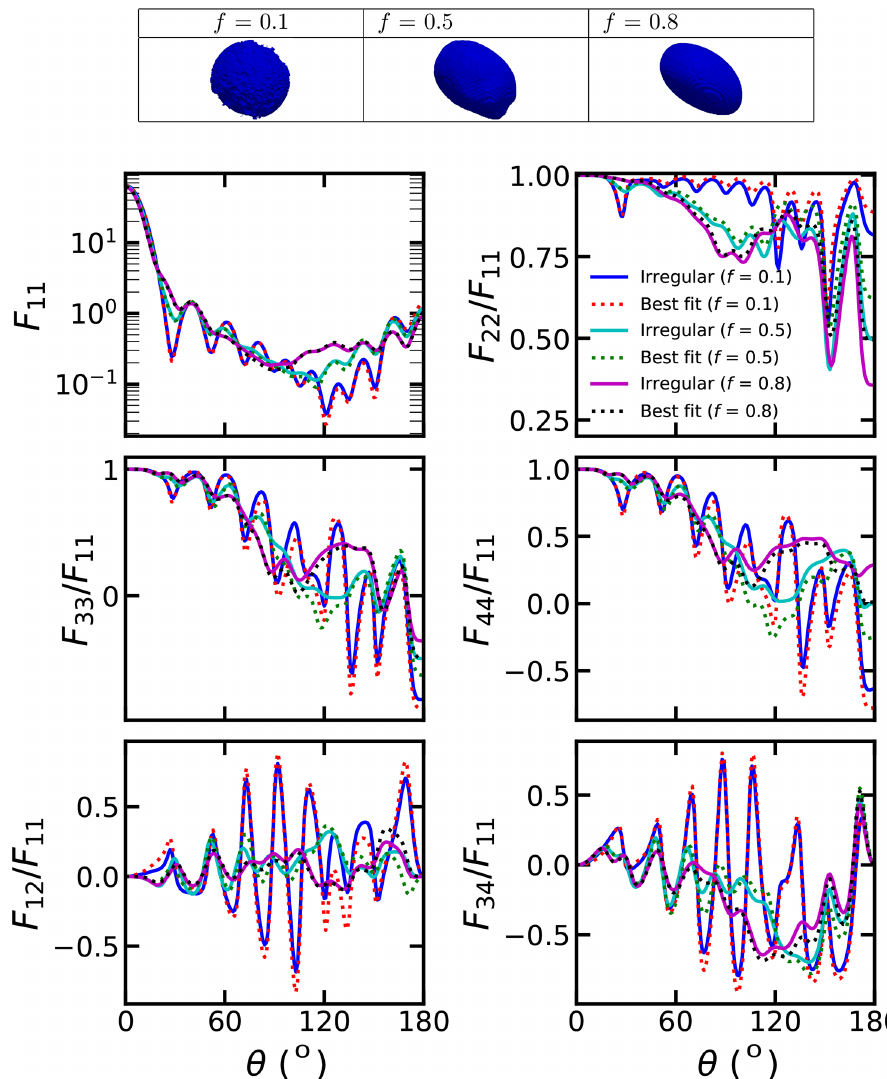
Figure 5. Similar to Fig. 4 but for an aspect ratio of 1 : 1.